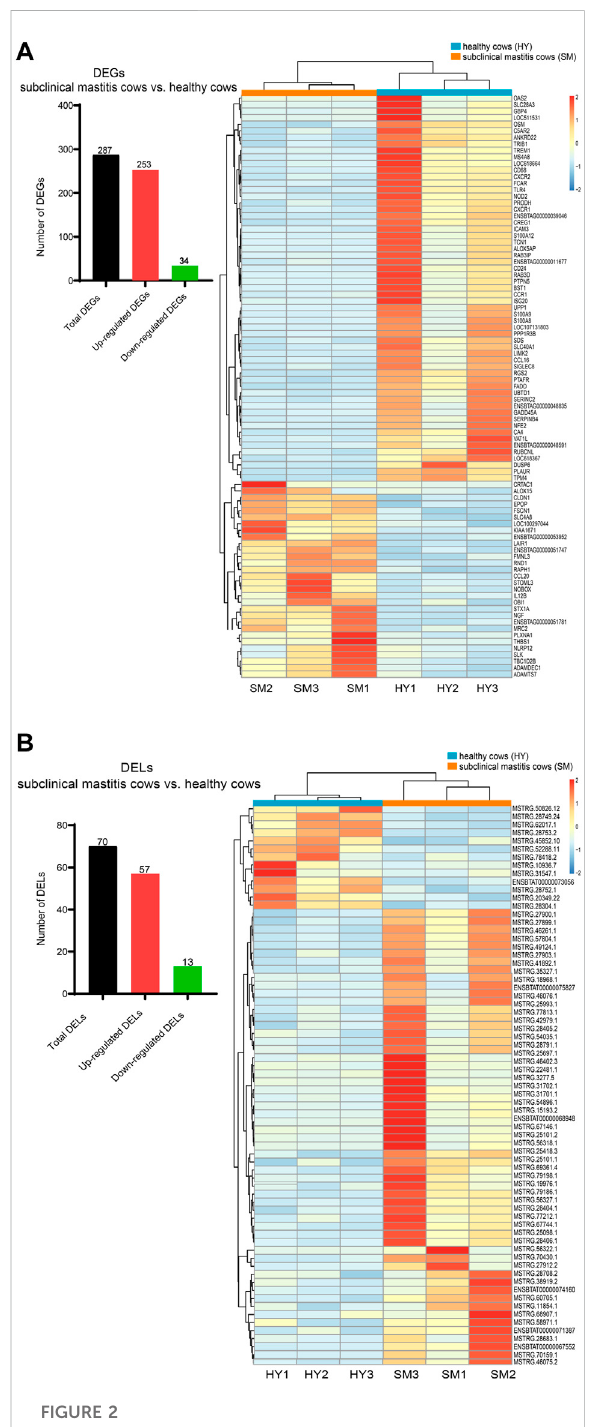
FIGURE 2 lncRNAs and mRNA expression pro fi le changes in subclinical mastitis cows vs. healthy cows. The number (A) and the heatmap (B) differentially expressed genes (DEGs) and differentially expressed lncRNAs (DELs) in subclinical mastitis (SM) cows vs. healthy (HY) cows ( p -value < 0.05, log2 (fold change) >